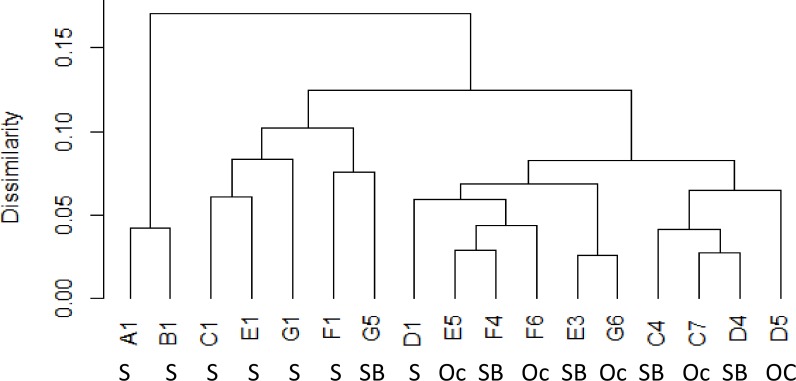
Dendrogram of the average Bray-Curtis distance between sites and site groupings based on environmental data (S = shelf, SB = Shelf break, Oc = oceanic station).